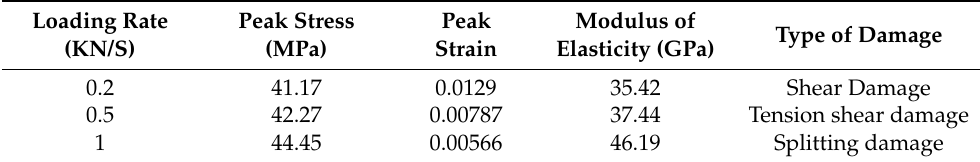
Figure 5. Failure modes of rock with different loading rates. Table 1. Table of mechanical parameters of uniaxial compression test.